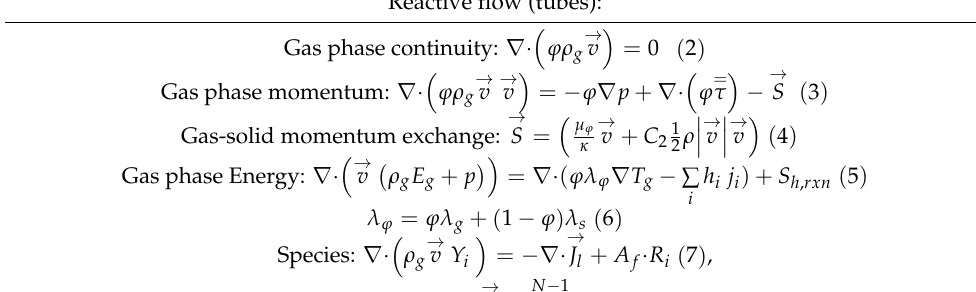
Table 3. Governing and constitutive equations used in this CFD model. Reactive flow